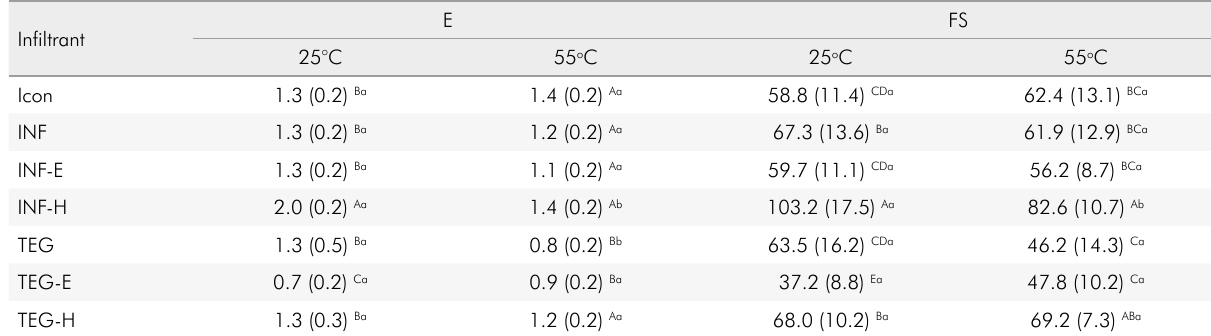
Table 3. Mean values of elastic modulus (GPa) and flexural strength (MPa) of infiltrants, according to temperature. Infiltrant